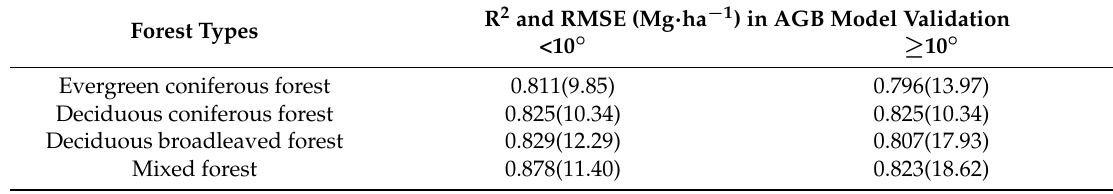
Table 8. AGB predicted from GLAS data on slopes <10 ◦ and ≥ 10 ◦ were compared with AGB converted from forest inventory data for four forest types. R 2 and RMSE (in parentheses) values correspond to each forest type.